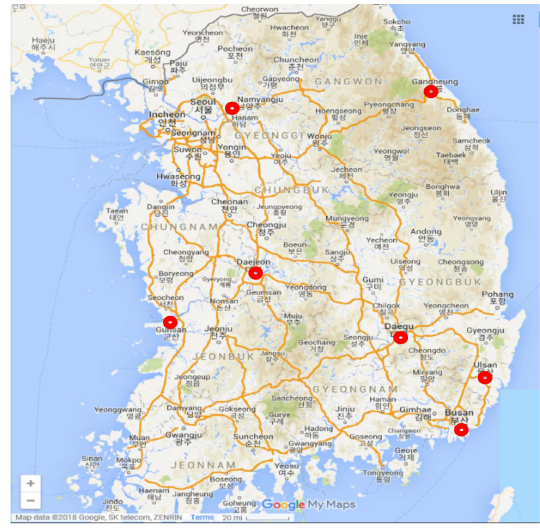
Figure 1. Cities where used porcelain insulators were